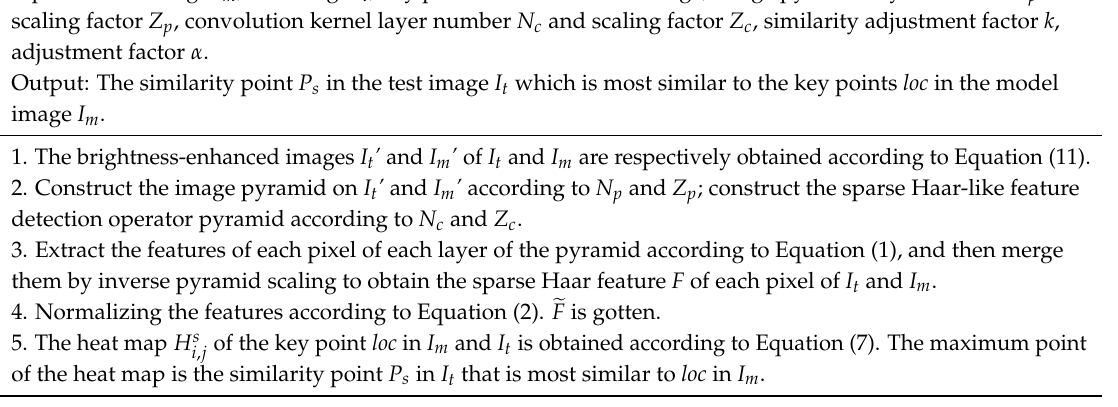
( b ) Figure 3. The results of Haar-like feature matching. ( a ) Low brightness; ( b ) High brightness. From the above, we can see that Haar-like features are not accurate enough, and are obviously influenced by the illumination. In order to improve the detection accuracy, a sparse Haar-like feature is proposed in this paper, as shown in Figure 4, where green stands for 1, black for − 1, and white for 0. In the figure, the first convolution kernel of edge feature and linear feature rotates 90°, 45° and 135° to get the last three. Figure 4. Improved sparse Haar-like feature operators. Let the size of convolution kernel be n × n , the rotation angle be θ , Ω b denote the black region, Ω g denote the green region, p b and p g denote the pixel points of the black and green regions. Thus, the calculation formula of the convolution feature is as follows: ( , )